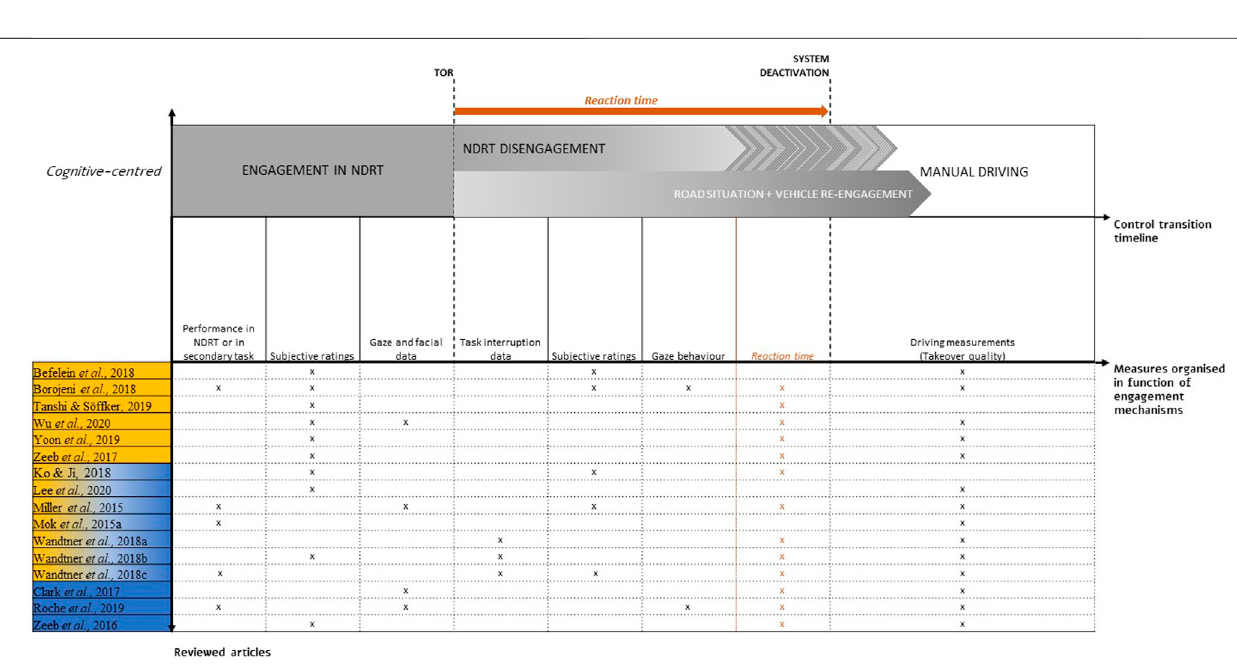
Frontiers in Future Transportation |